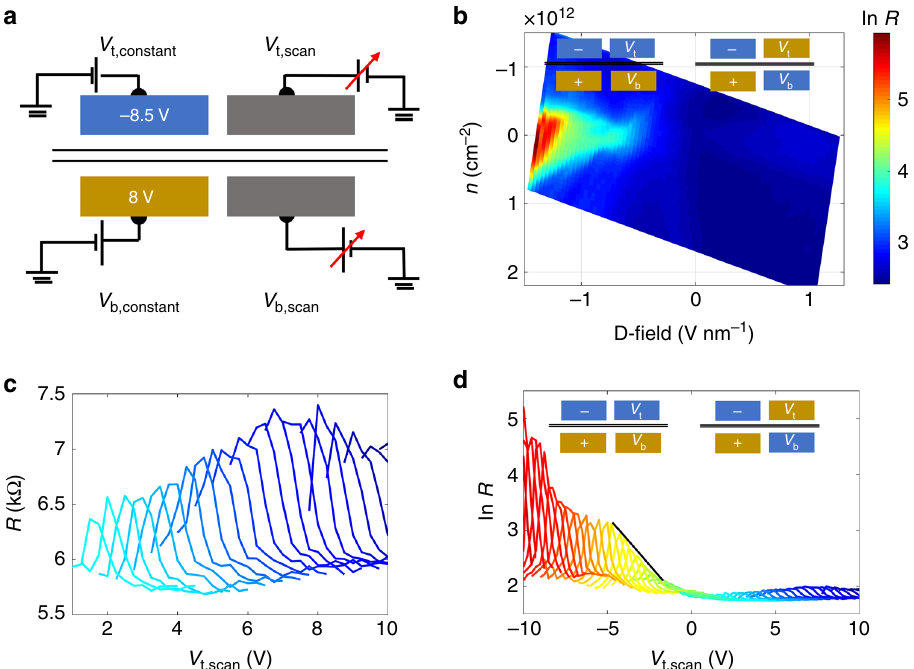
Fig. 4 Formation of chiral states with opposite direction: measurement results when left gates are fi xed at negative polarity, from device 1. a Cross- section view of measurement setup, the left side displacement fi eld is opposite to that in Fig. 3. b BLG resistance (in log scale) color plot as a function of displacement fi eld and charge-carrier density n . c Zoom-in view of right side of d , corresponds to oddly gated con fi gurations. d BLG resistance (in log scale) as a function of the top-gate potential when the bottom gate is fi xed at different potentials. Peak values of curves grow linearly with increasing D - fi eld with a straight line as a guide to the